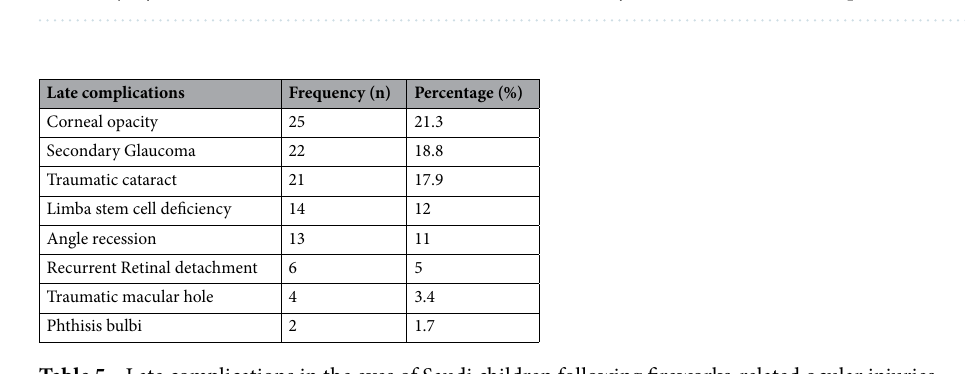
Table 4. Visual outcomes stratified by the type of the first surgery performed to manage fireworks-related ocular injury in Saudi children. BCVA best corrected visual acuity, IOL intraocular lens implantation.